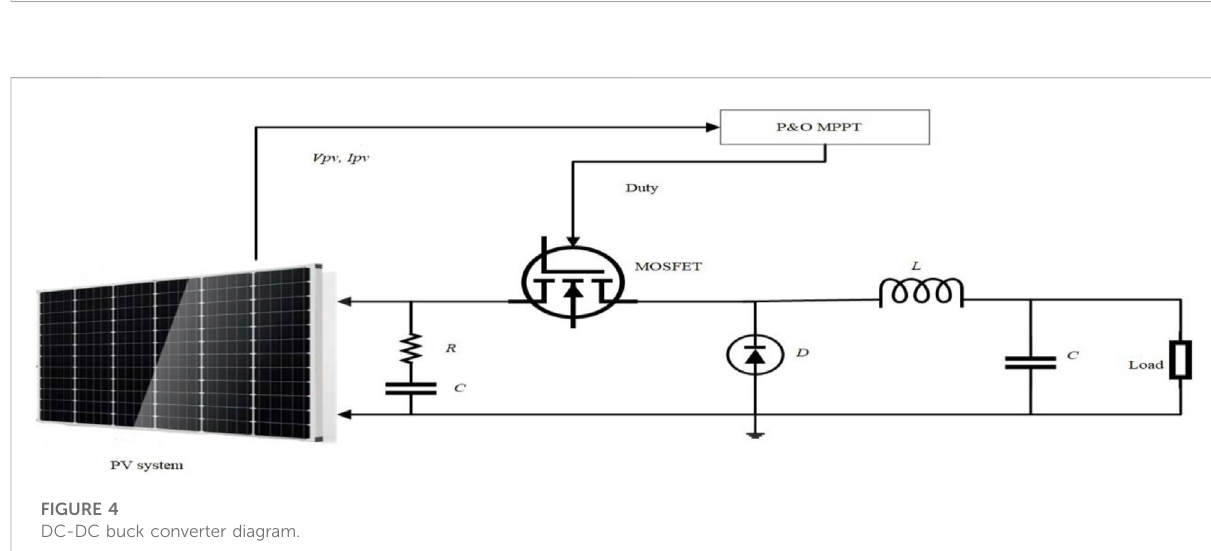
FIGURE 4 DC-DC buck converter